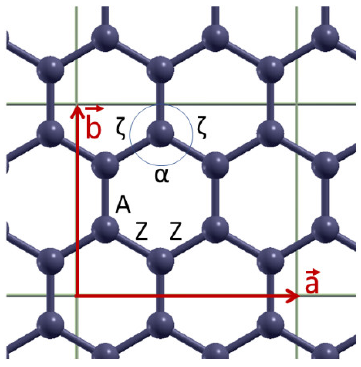
Figure 1. The rectangular 8-atom unit-cell considered for our DFT calculations, where bonds of A and Z type and angles of α and ζ type are shown. These bonds and angles are no longer equivalent for finite uniaxial strains along either zigzag (horizontal) or armchair (vertical) directions.